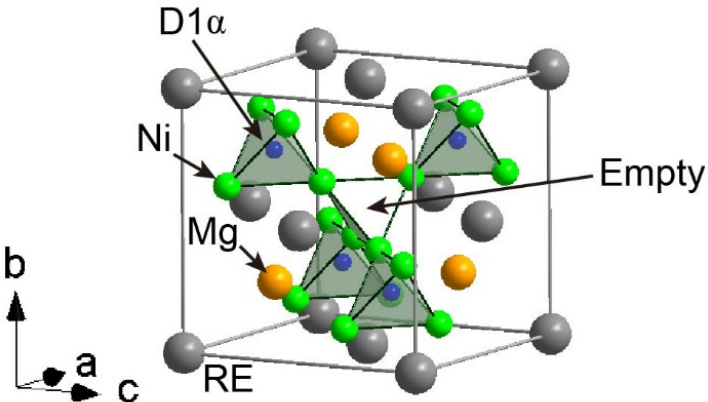
Figure 3. Crystal structure of α hydride based on LaMgNi 4 D 0.75 [24]. The RE, Mg, and Ni D atoms are represented by grey, orange, and green spheres, respectively. The corner-shared tetrahedra formed by four Ni atoms are represented as the green polyhedra. The D atoms in the crystal structure are indicated as D1 α .